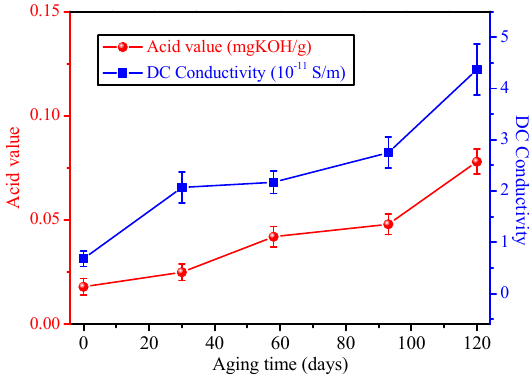
Figure 5. Relationships between the acid value, DC conductivity, and aging time of mineral insulating oil.